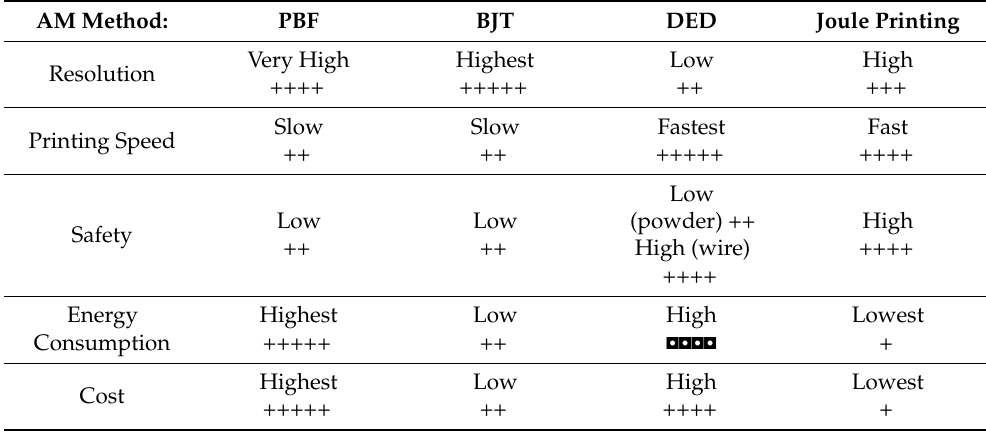
Table 2. Comparison between different AM techniques. Table 2 . Comparison between different AM techniques. Table 2 . Comparison between different AM techniques. Table 2 . Comparison between different AM techniques. Table 2 . Comparison between different AM